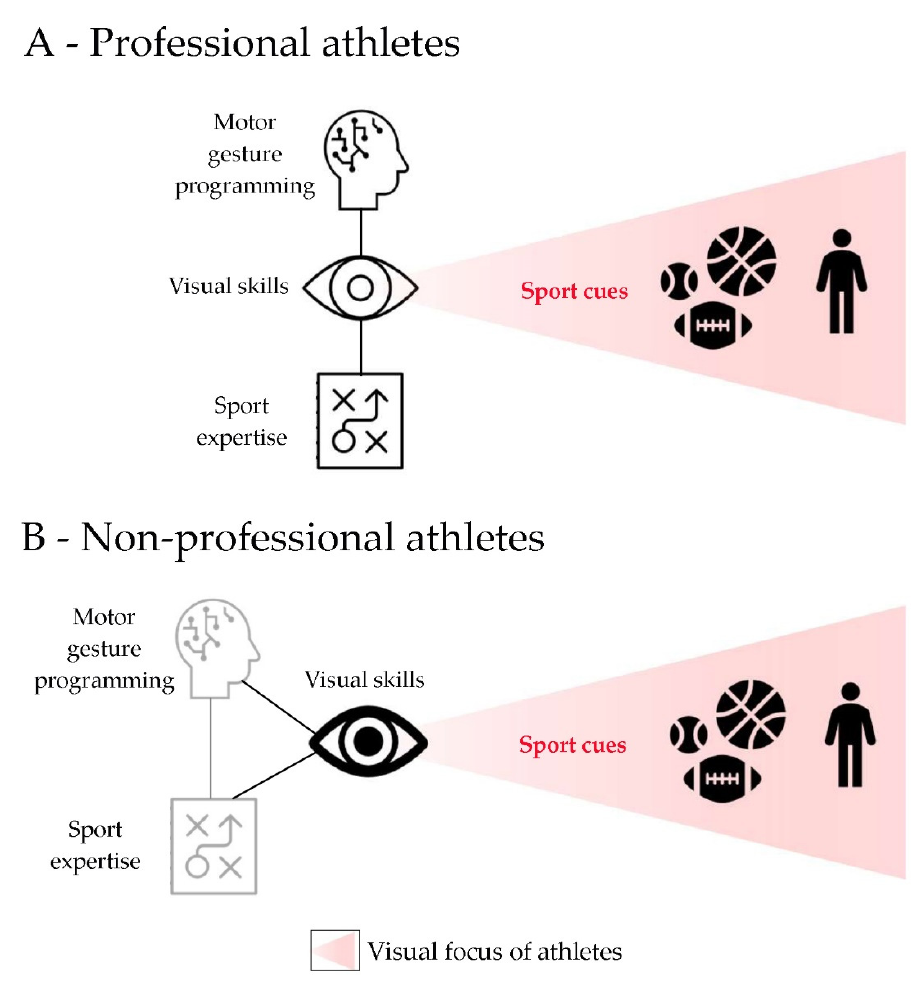
Figure 3. Proposed scheme of visuomotor integration model in professional panel ( A ) and non-pro- fessional panel ( B ) athletes. ( A ) Visual input and skills are integrated with motor control and sport expertise in professional athletes. ( B ) Visual abilities are the main component by which non-profes- sionals compensate for the absence of sport experience in the programming of motor gestures. The blurred ray identifies the visual focus of athletes.